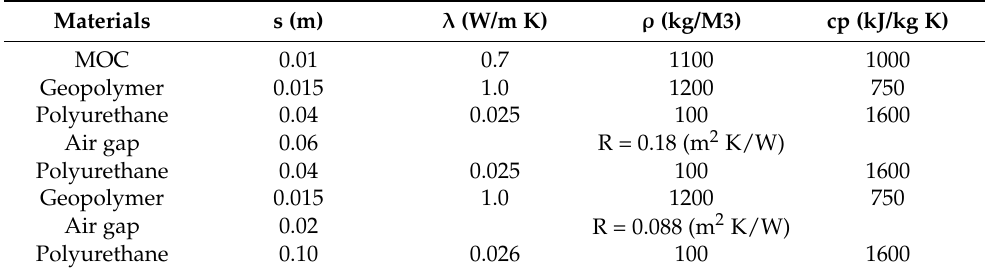
Table 1. Properties of the basic design